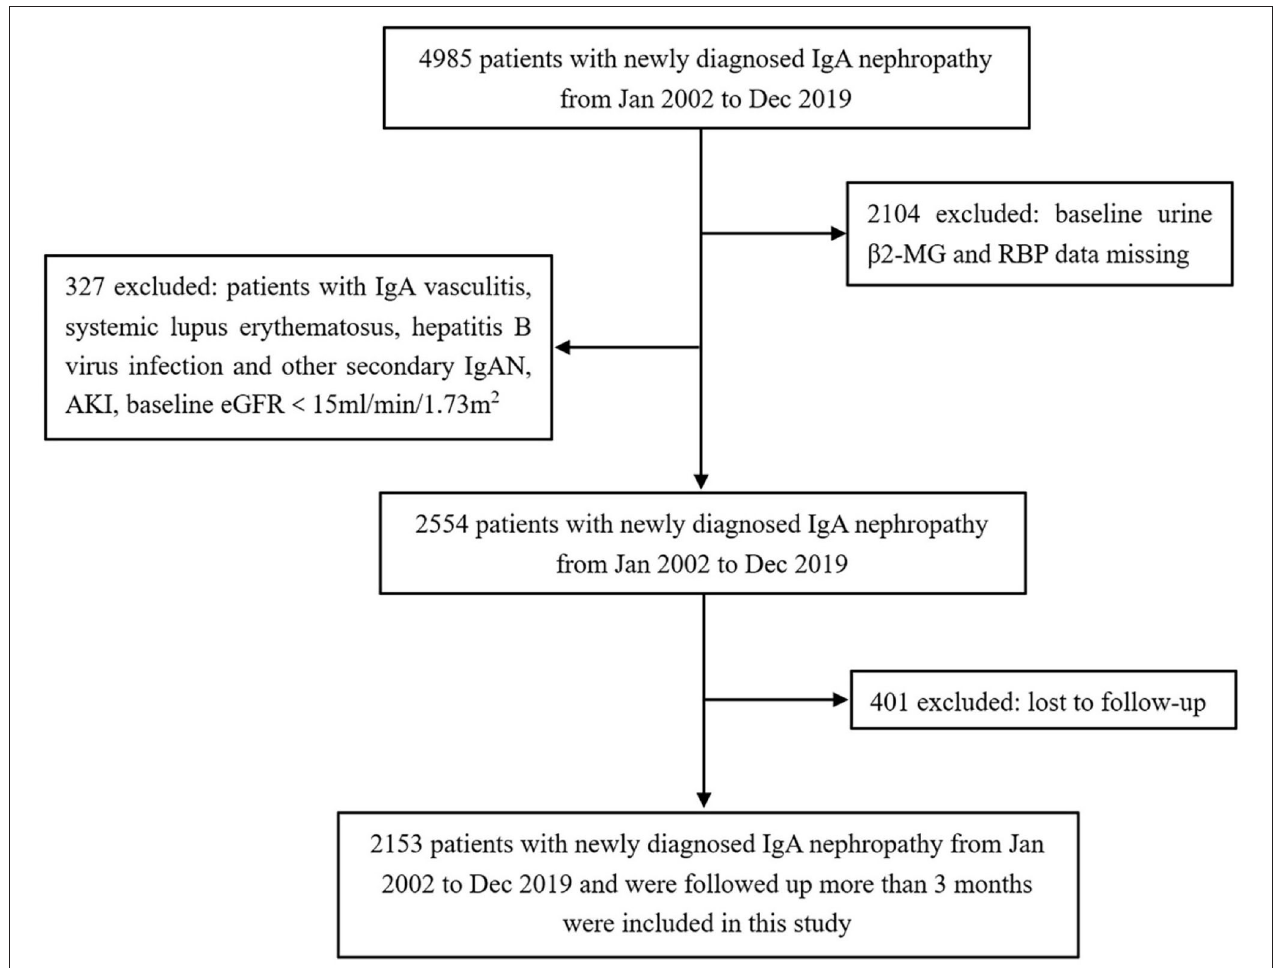
FIGURE 1 | Flowchart of participants in the cohort. β 2-MG, β 2-microglobulin; RBP, retinol-binding protein; IgAN, IgA nephropathy; AKI, acute kidney injury; eGFR, estimated glomerular filtration rate.